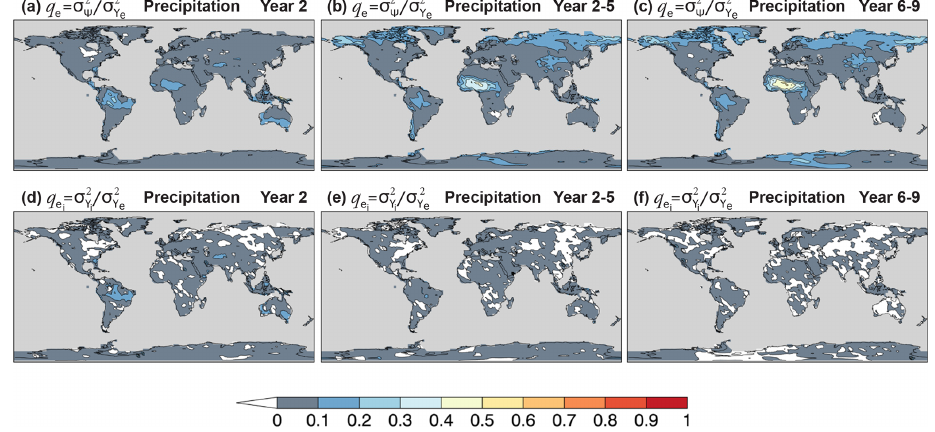
Figure 12. Potential predictability of CanESM5 annual and multi-year precipitation hindcasts. (a–c) Potentially predictable variance frac- /σ 2 , Eq. (4), and (d–f) the portion q e tion q e = σ 2 (cid:57) Y e (c, f) Year